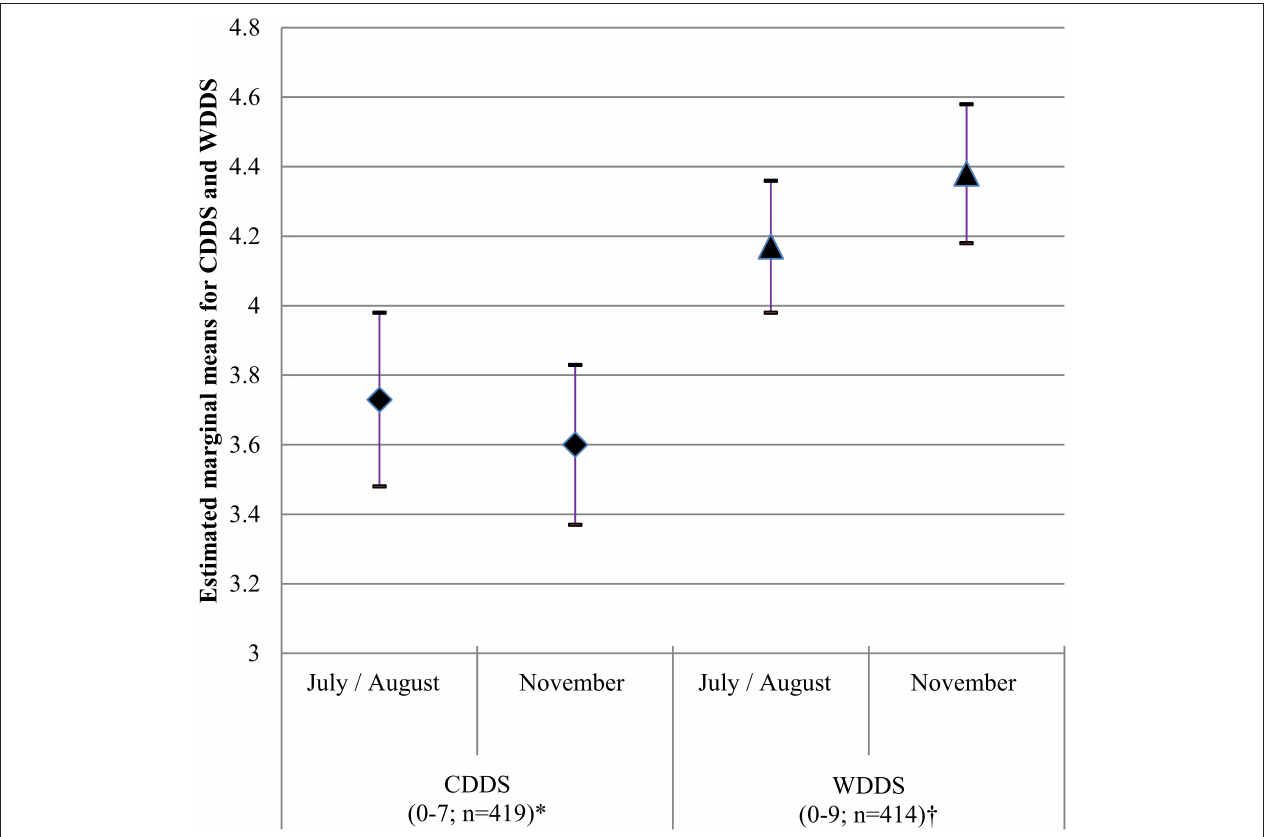
FIGURE 3 | Estimated marginal means, 5th and 95th CI for WDDS ( n = 414) and CDDS ( n = 419) in July/August and November 2012 in Western Kenya. Covariates included in GENLINMIXED models: *age of women (years), education of women (years), wealth index, household size, household hunger scale score, home gardening, ethnic group, agro-ecological zone and sub-county, †age of children (months), wealth index, ethnic group, household size, household hunger scale score, home gardening, and agro-ecological zone and sub-county.